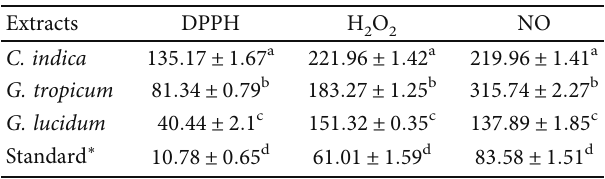
Table 4: IC ( μ g/mL) values of various ethanolic mushroom 50 extracts and standard in di ff erent antioxidant